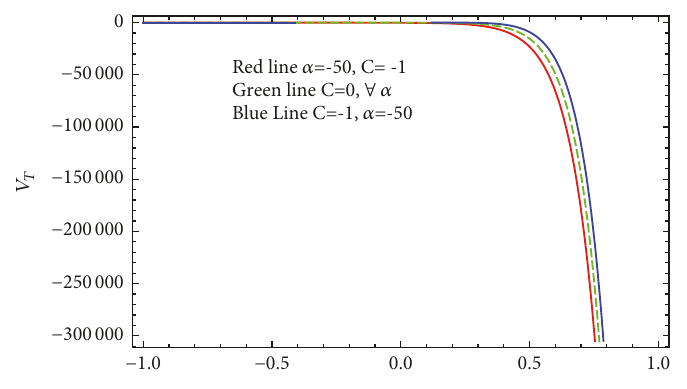
Figure 2: Potential versus redshift